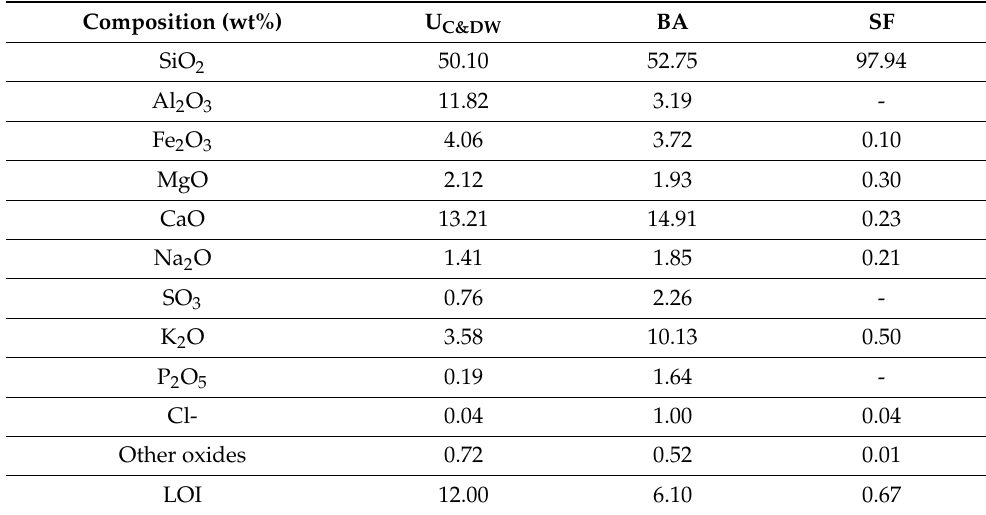
Table 1. SCM chemical composition.